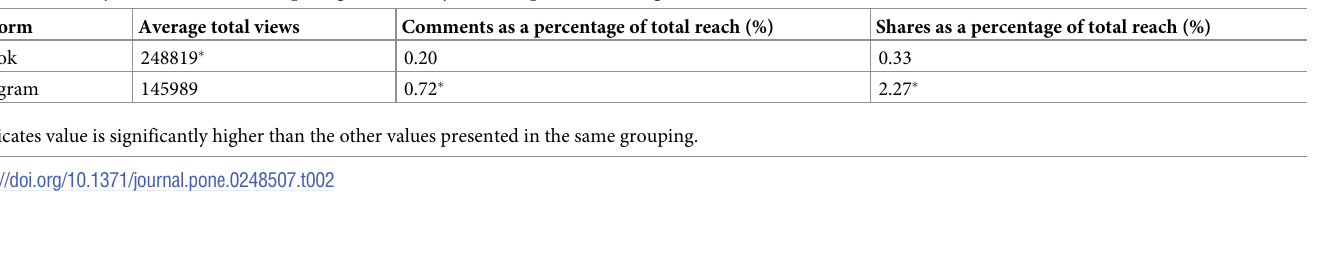
Table 2. Summary of data collected comparing the same style of ESC posted to Instagram and TikTok. Platform Average total views Comments as a percentage of total reach (%) Shares as a percentage of total reach (%)